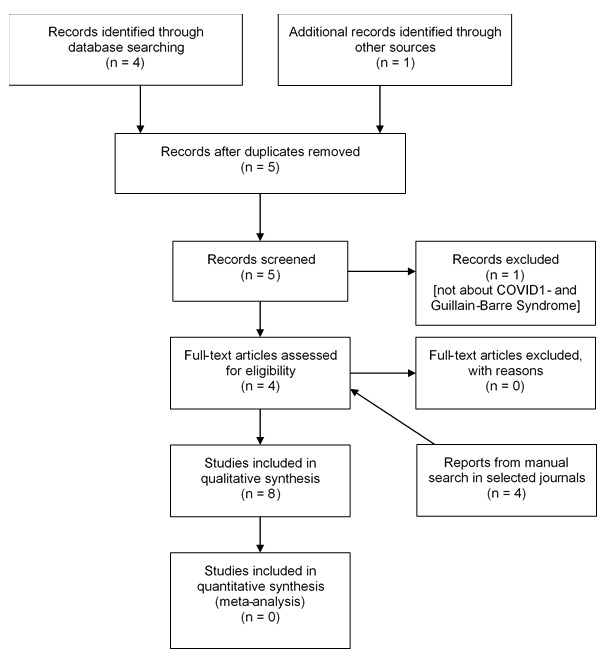
Selection process.